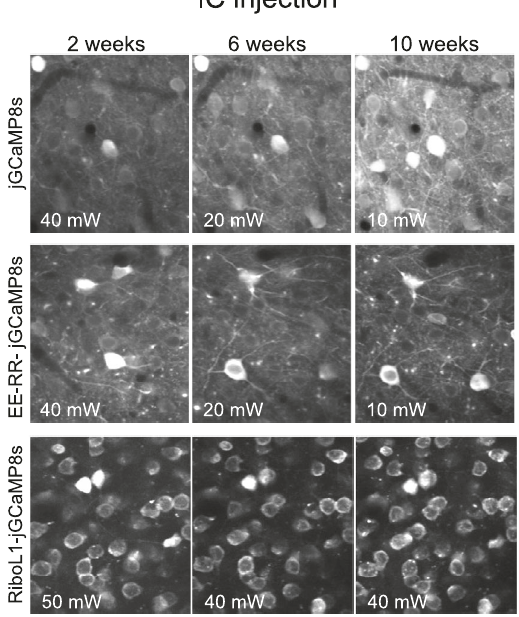
relatively weak, but when using the same construct with IC injections a large population of neurons could be detected and the signal intensity remained stable throughout the experimental period. All images shown are average intensity pro- jectionsfrom250frameswithidenticaladjustmentstobrightnessandcontrast,and the results were reproduced in ≥ 3 mice. Scale bar indicates 30 µ